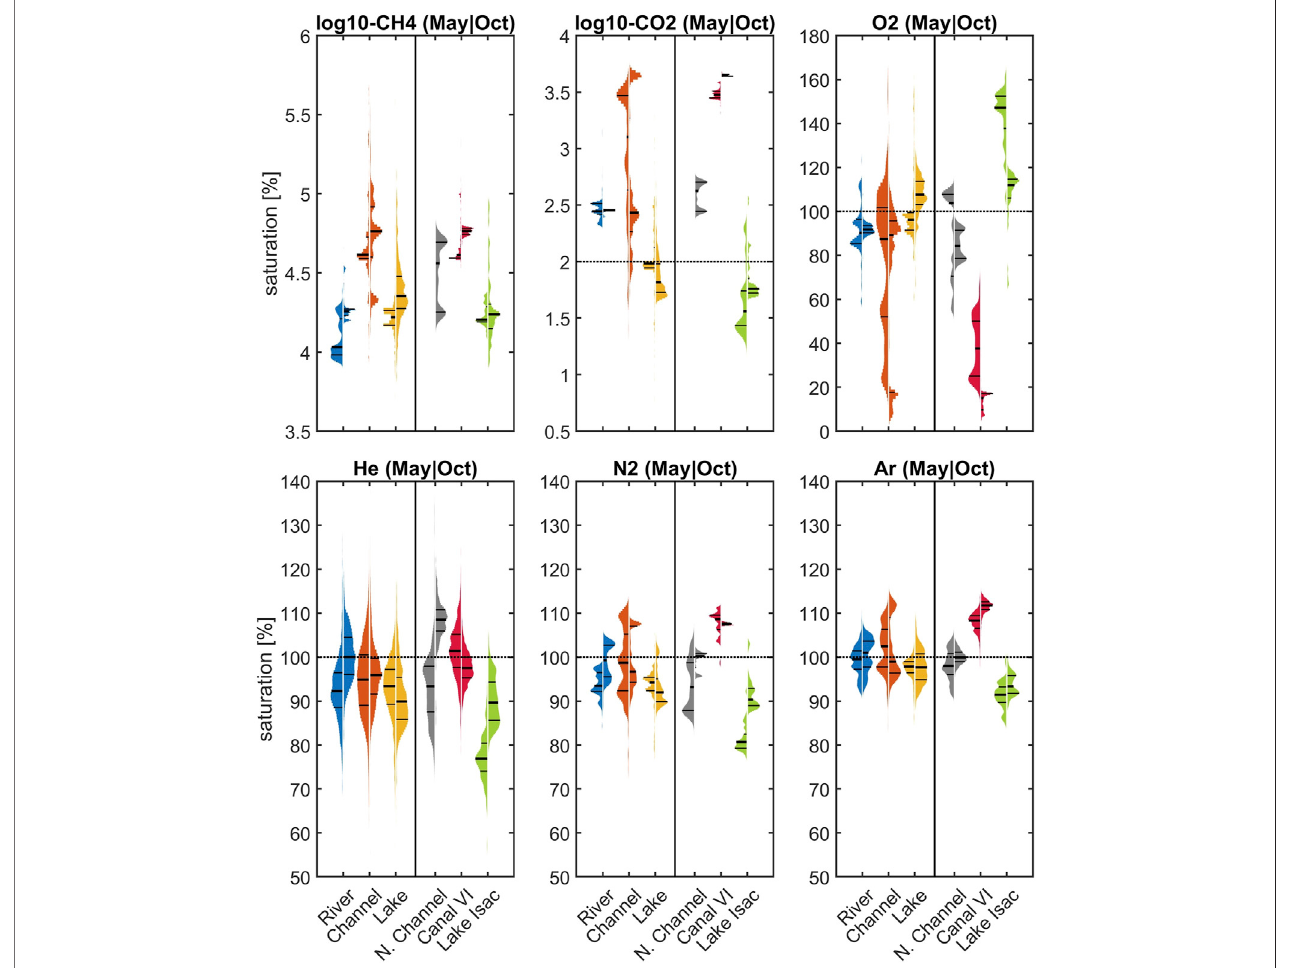
FIGURE 6 | Variability in CH 4 , CO 2 , O 2 , He, N 2 and Ar saturations with respect to different waterscapes (river, channel, lake) and three selected areas in May (left distribution) and October (distribution on the right). Horizontal lines in the distributions mark the 25th, 50th and 75th percentile. Horizontal dotted lines represent 100% saturation.IncaseofCH 4 thislineisbelowtheselectedplottedarea.Pleasenotethedifferentscalingofthe y -axisandtherepresentationofCH 4 andCO 2 aslog 10 ().See boxes in Figure 1 for the location of the speci fi c areas Northern Channels, Canal Vatafu-Imputita and Lake Isac and Supplementary Tables S3 and S4